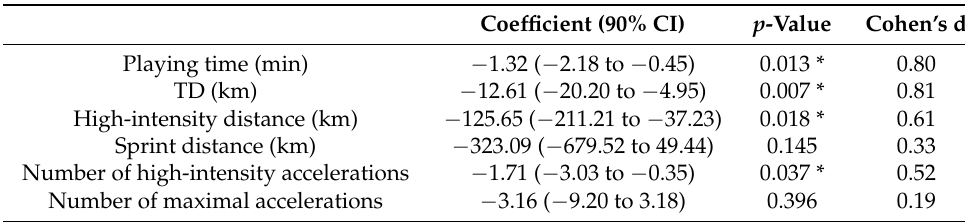
Table 1. Effects of playing time and physical performance on s-IgA differences calculated between 30-min post-match and 60-min before kick-off time points.